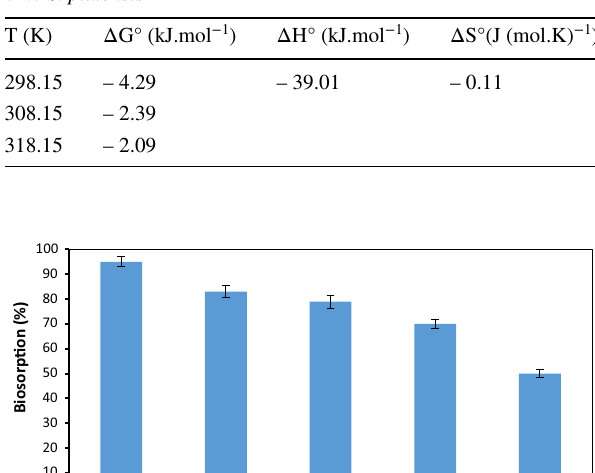
Table 8 Thermodynamics parameters for malachite green sorption onto S. platensis